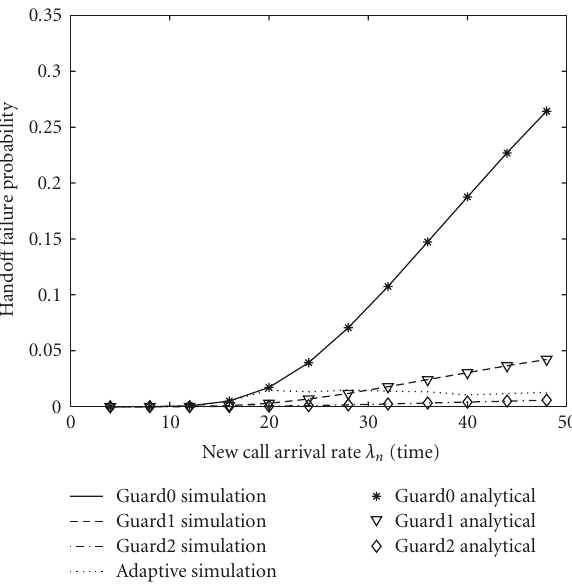
Figure 6: Analytical and simulation results of hando ff failure probability for the two-cell system.